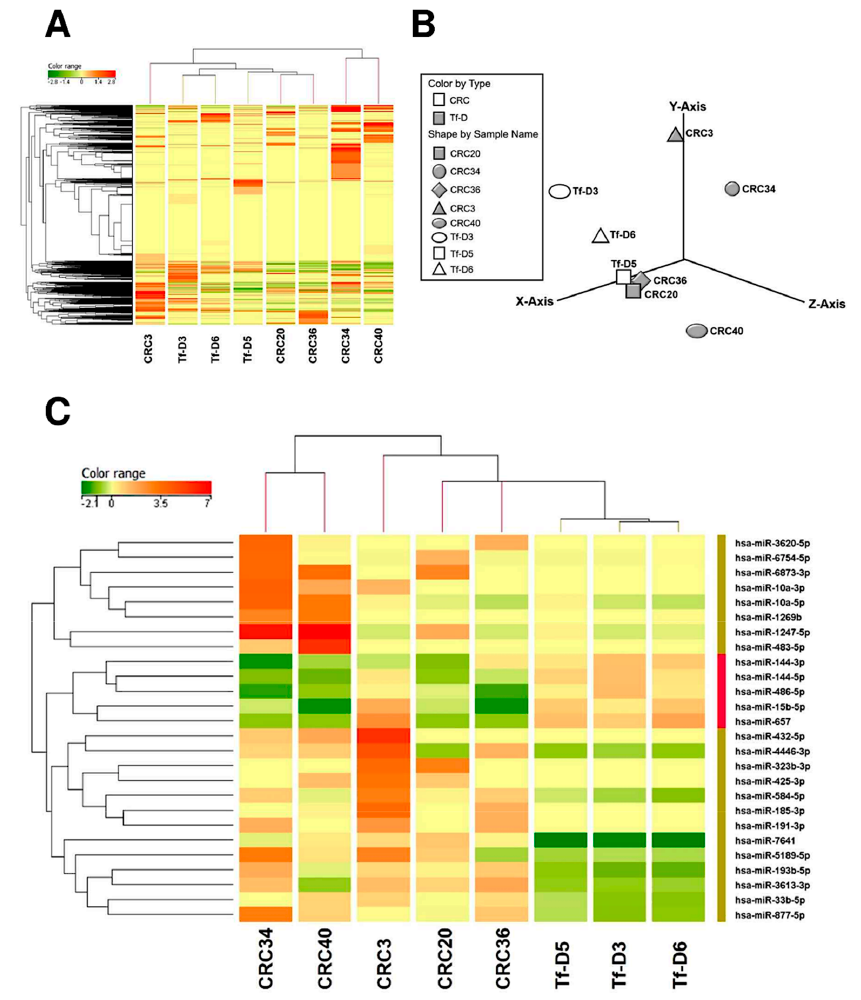
Figure 2. miRNome analysis. ( A ): Hierarchical clustering of the miRNAs identified in each expression of library pattern. The miRNAs were from tumor-free donors (Tf-D) and colorectal cancer (CRC) patients’ blood samples. Green = down-regulation; red = up-regulation. ( B ): Profile of overall miRNAs expression changes. The di ff erential expression levels of miRNA in library (CRC) versus healthy groups. Each shape in the 3D visualization represents a group of miRNAs. Principal component analysis (PCA) captured the variation observed in the experiment in the first three principal components (PC). ( C ): The heatmaps of CRC samples versus tumor-free plasmas are shown in Figure S1 (FC > 1.5) and in Figure 2C (FC >